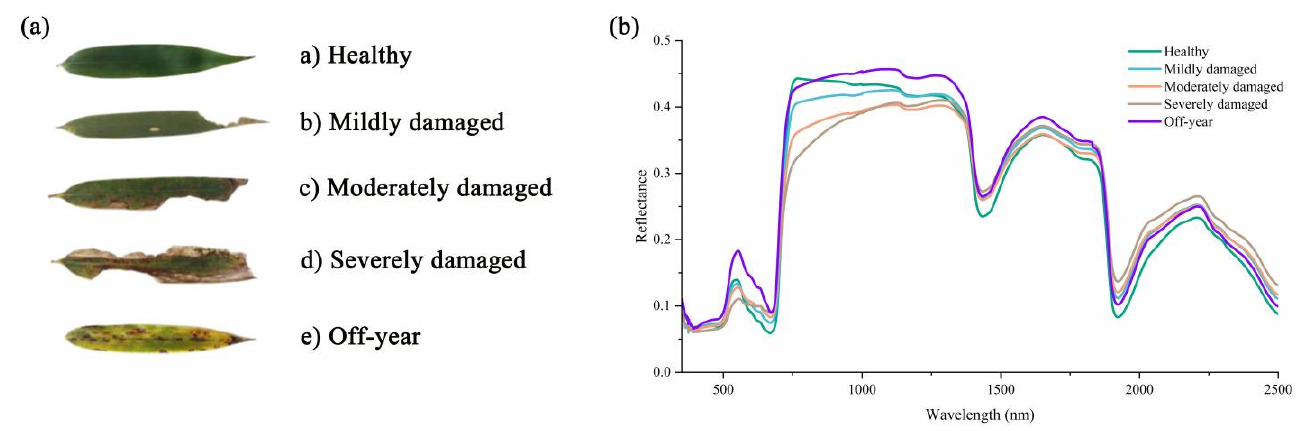
Table 3. Paired t -test of spectra for leaves with different damage levels.